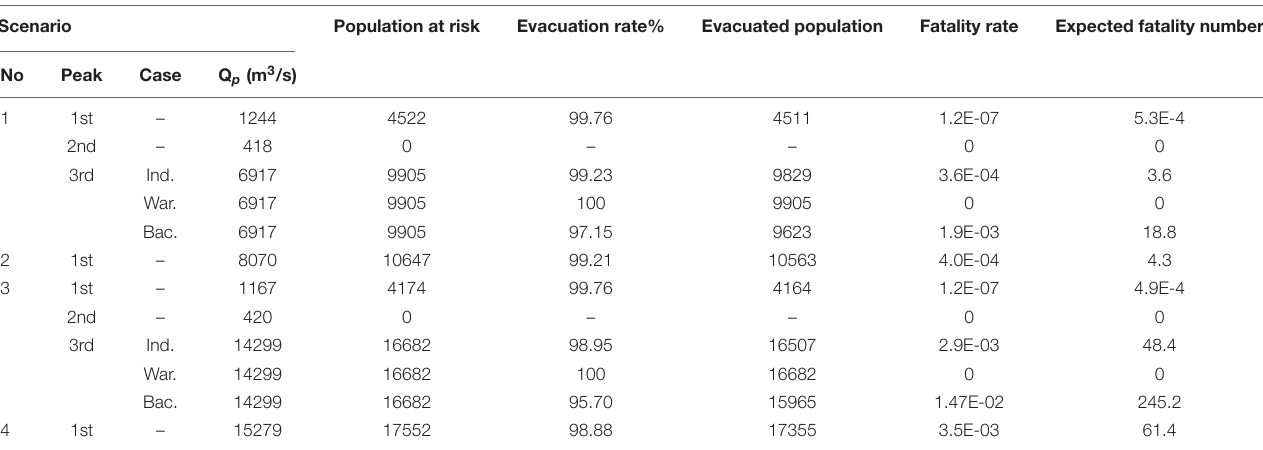
TABLE 5 | Risk assessment results in Beichuan